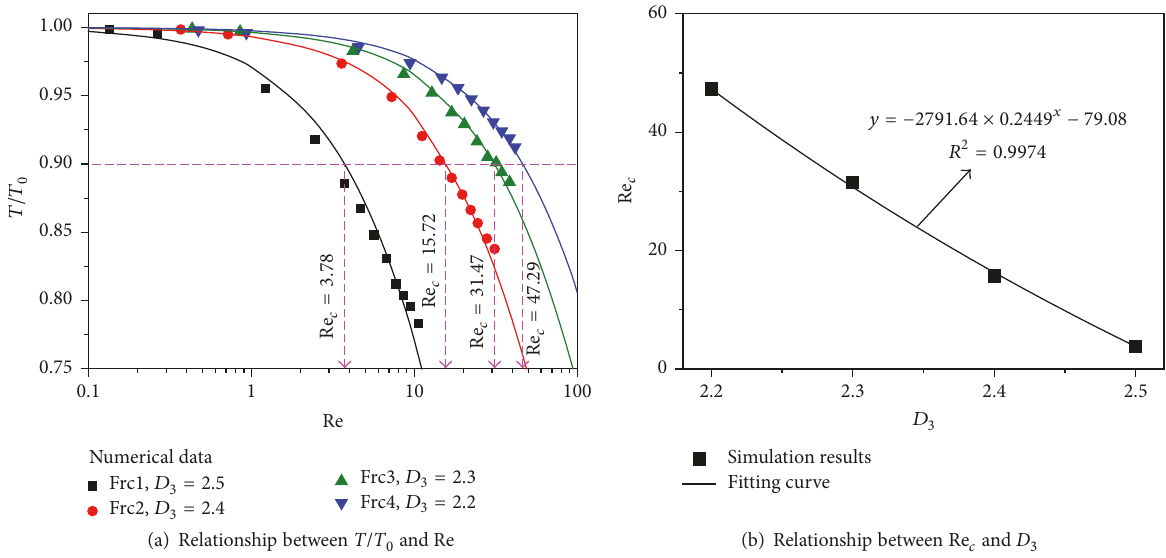
Figure 14: Relationships between (a) T / T 0 and Re and (b) Re 𝑐 and D 3 based on the data replotted from Wang et al. ([47], Figure 16 ).